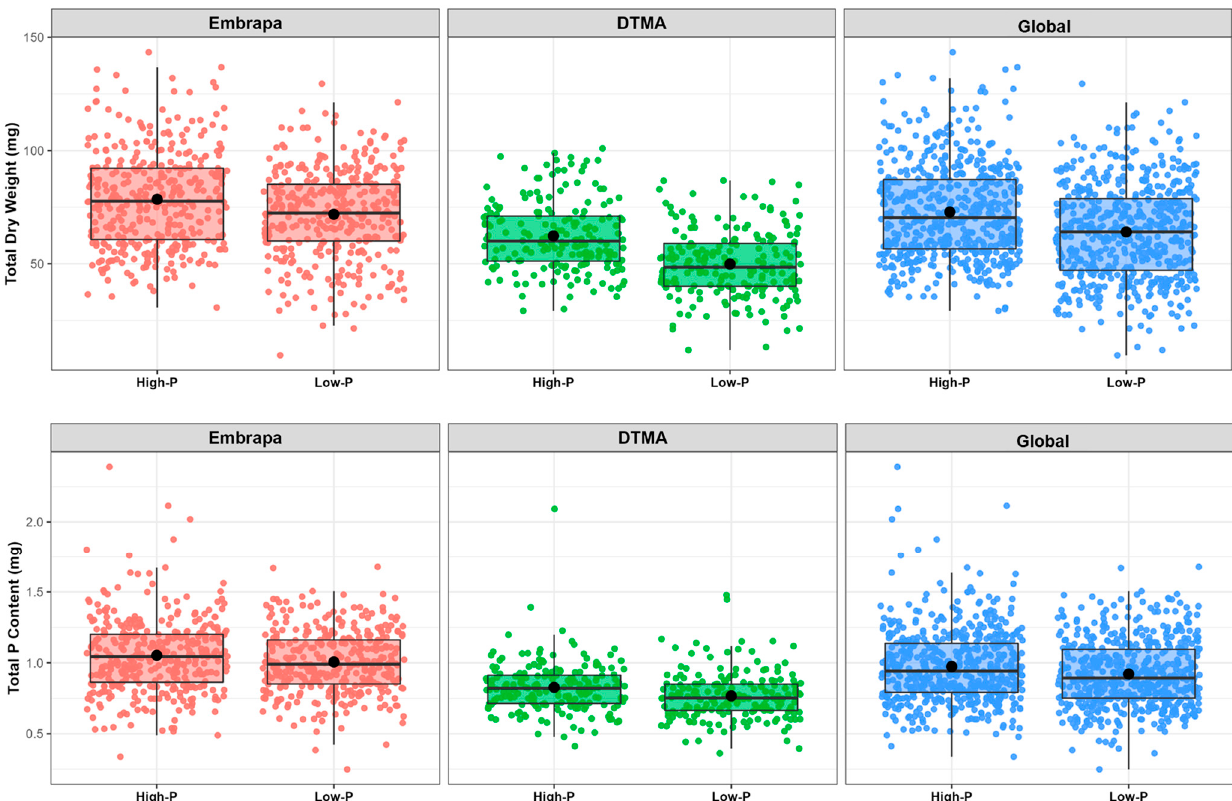
Figure 3. Boxplot showing the biomass accumulation and P content in the seedlings distribution over the Embrapa, DTMA and global maize panels in high- and low-P concentrations. Phenotypes were BLUEs for total seedling dry weight in mg (TDW) and total P content in mg (PCont).